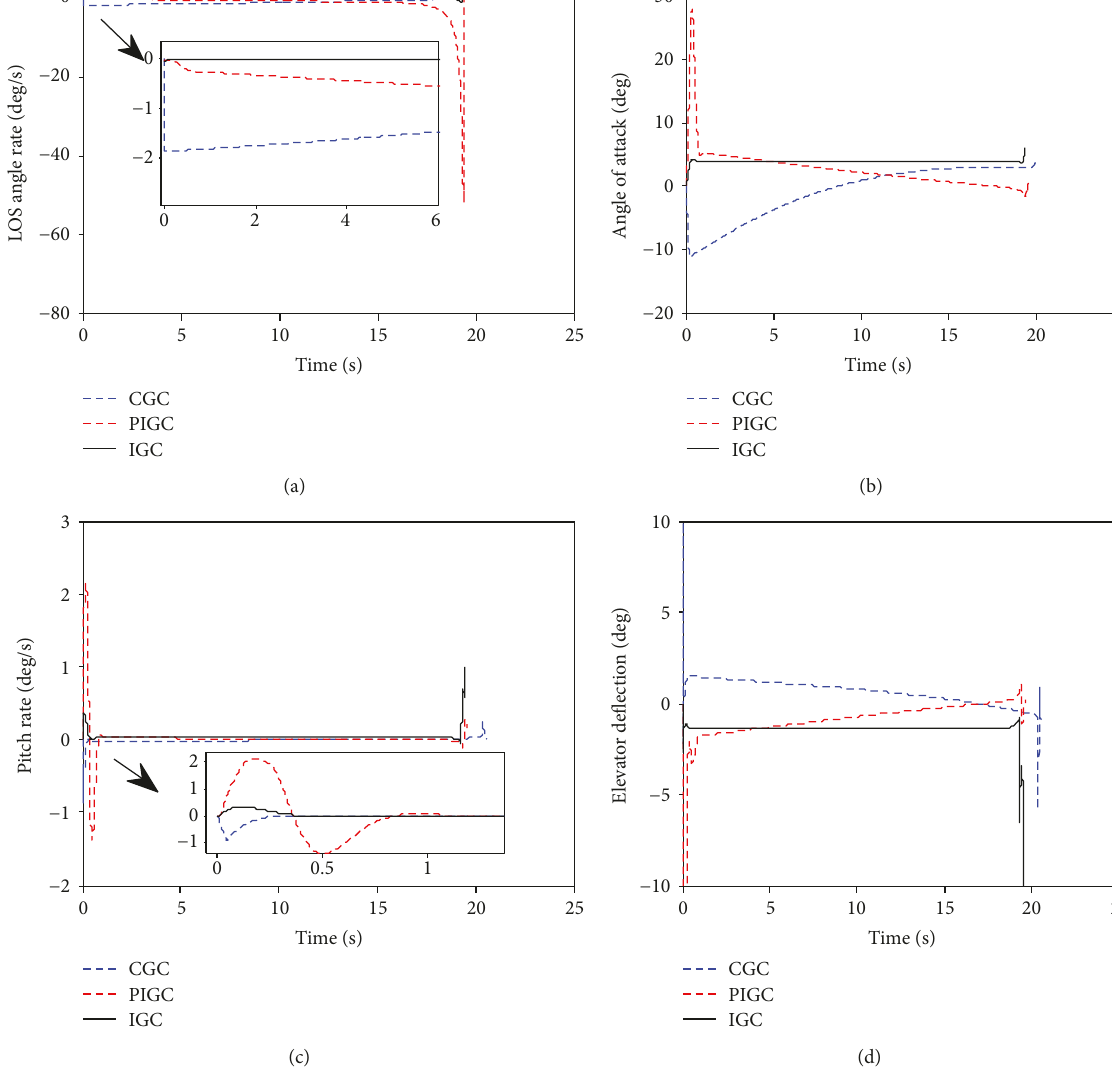
Figure 2: Variable response curves under the three control laws against a fi xed